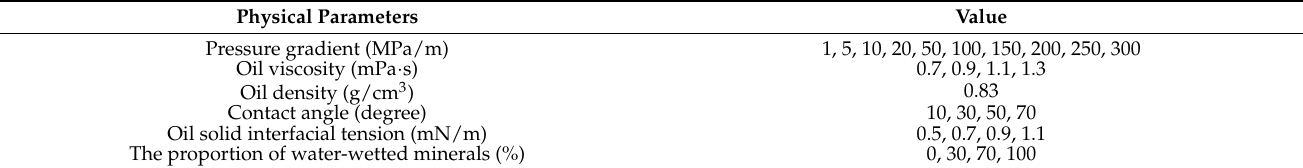
Table 5. Flow simulation